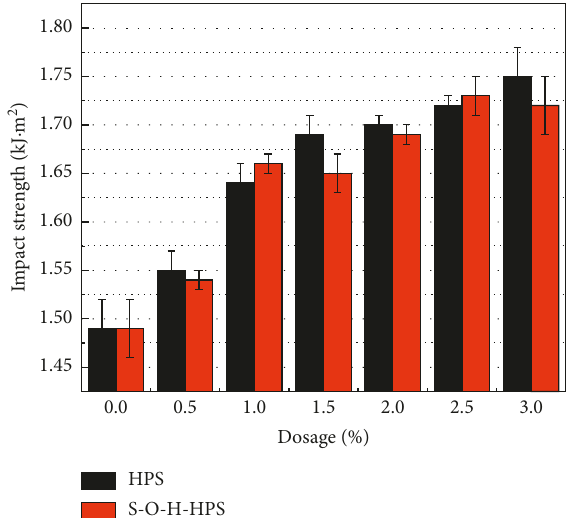
Figure 8: Effect of additive on impact strength of cement stone.